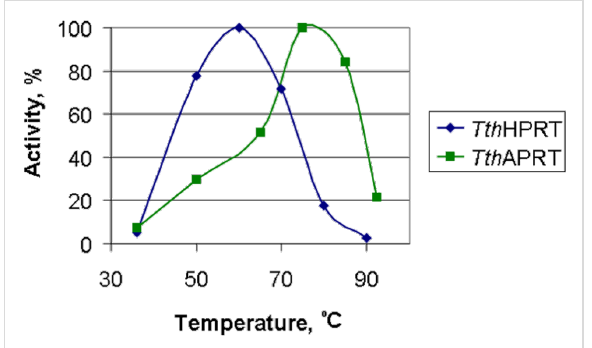
Figure 3: Dependence of Tth HPRT and Tth APRT activity on tempera- ture (reaction mixtures (0.5 mL) contained 20 mM Tris-HCl, pH 8.0, 1 mM 5-phosphoribosyl-1- α -pyrophosphate, and 5 mM MgCl 2 ; in the case of Tth HPRT mixtures contained 1 mM hypoxanthine and 0.18 μ g